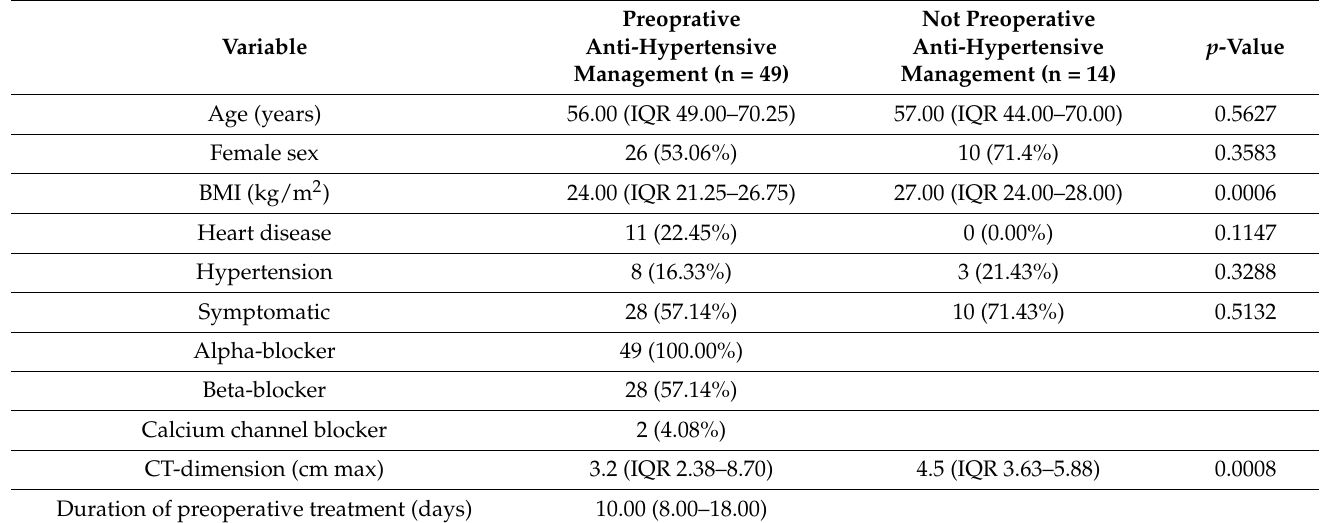
Table 1. Basal characteristics of the two groups.